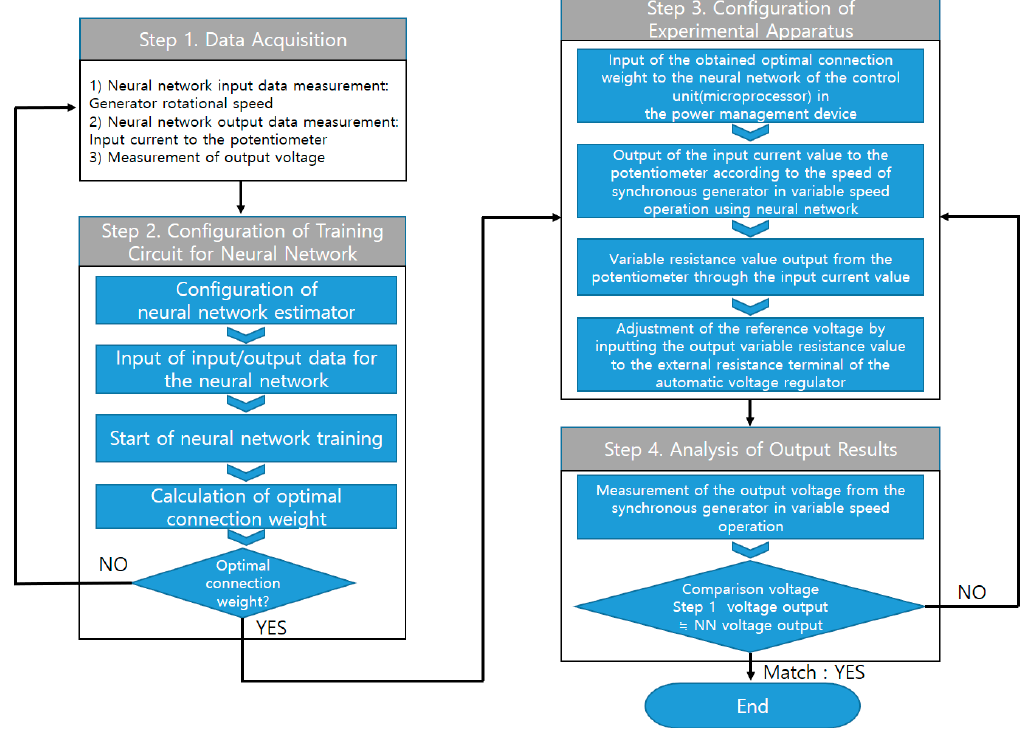
Figure 5. Reference voltage control with variable speed synchronous generator engine .